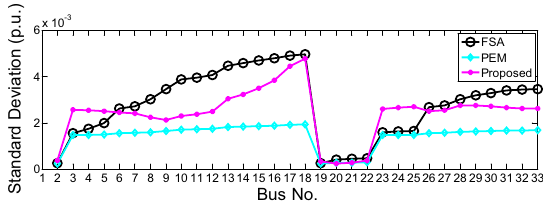
Fig. 8 Standard deviation of the elements in bus voltage